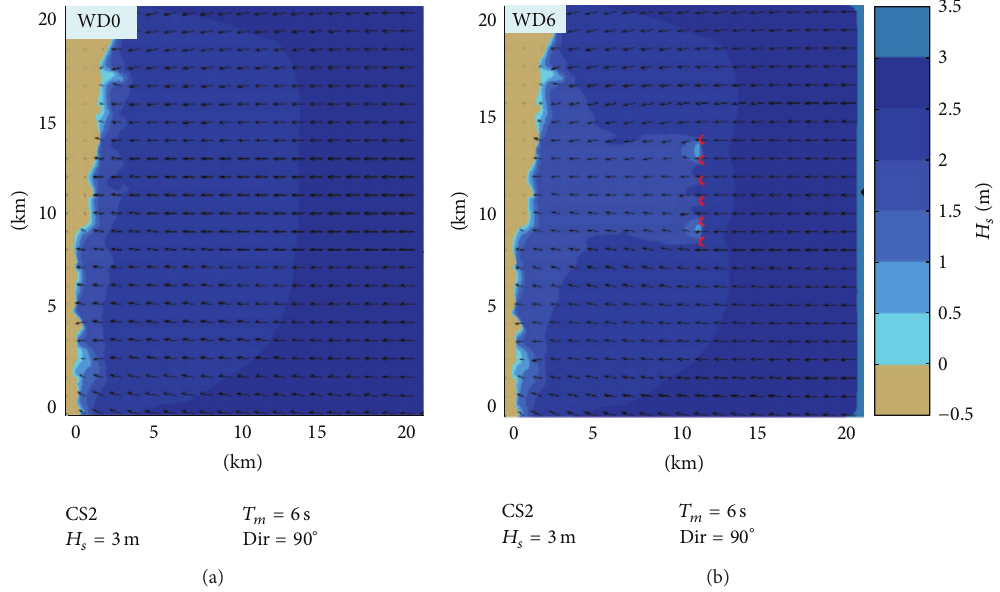
Figure 7: Evaluation in the geographical space of the impact on the wave field of a wave farm based on Wave Dragon WECs that operate in the target area. CS2—high energetic conditions and waves coming from east ( 90 ∘ in nautical convention). (a) SWAN simulation in the case WD0. (b) SWAN simulation for the case WD6. The 𝐻 𝑠 scalar fields are presented in the background while in the foreground the wave vectors are